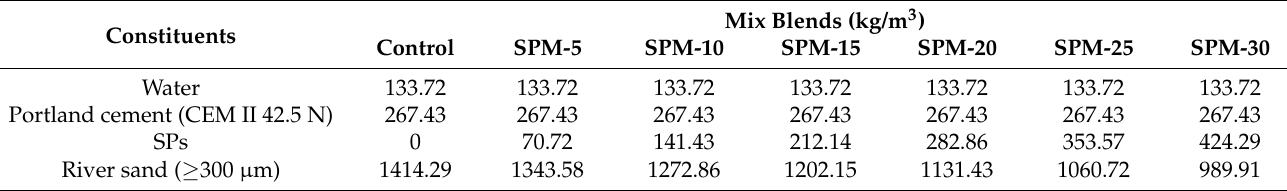
Table 4. Mix constituents of SP-blended